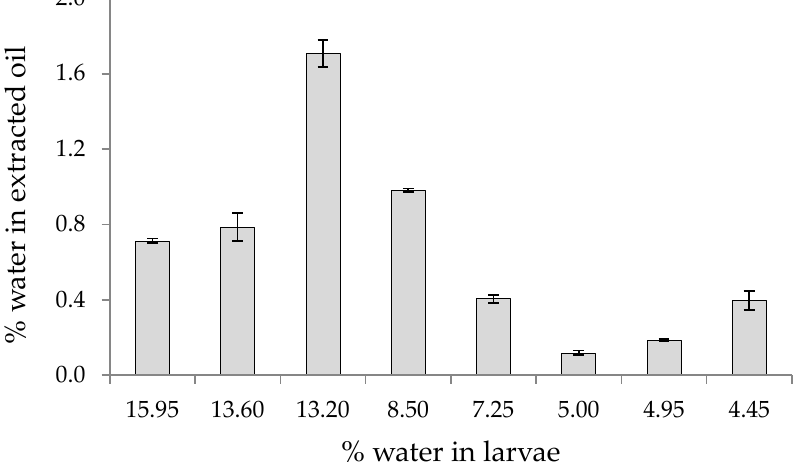
Figure 6. Moisture content (% w/w) in the oil extracted from the different samples of H. illucens larvae as a function of the initial moisture content in the larvae.